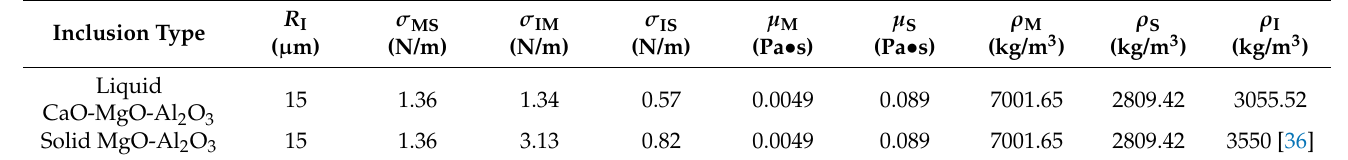
Figure 12. The displacement of different inclusions at the interface between steel and slag. Table 3. Calculated values of inclusion radius, interfacial tension, density, and